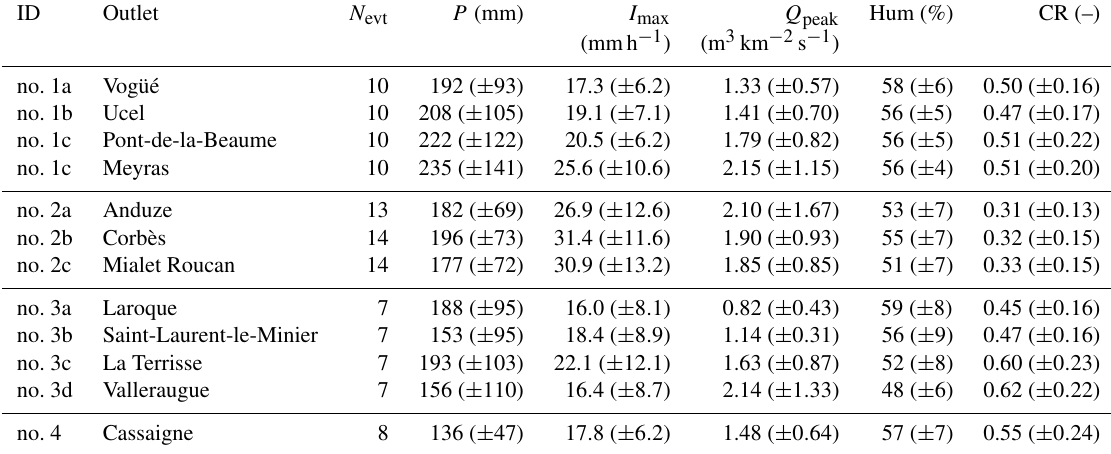
Table 2. Properties of the flash flood events as an average on the event set ( ± standard deviation). ID is the coding name of the concerned catchments (See Fig. 1: no. 1 for the Ardèche, no. 2 for the Gard, no. 3 for the Hérault and no. 4 for the Salz); N evt is the number of observed flash flood events; P (mm) is the mean precipitation; I max (mmh − 1 ) is the maximal intensity rainfall per event; Q peak is the specific flood peak (m 3 km − 2 s − 1 ); Hum is the initial soil moil moisture according to SIM output (Habets et al., 2008); CR is the runoff coefficient